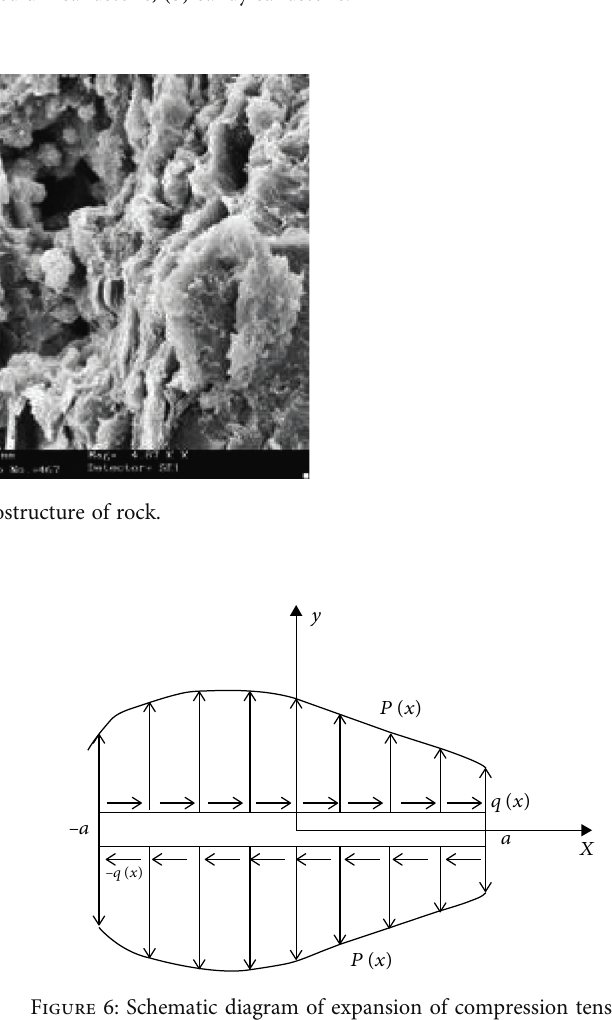
Figure 5: Schematic diagram of expansion of compression shear crack tip.